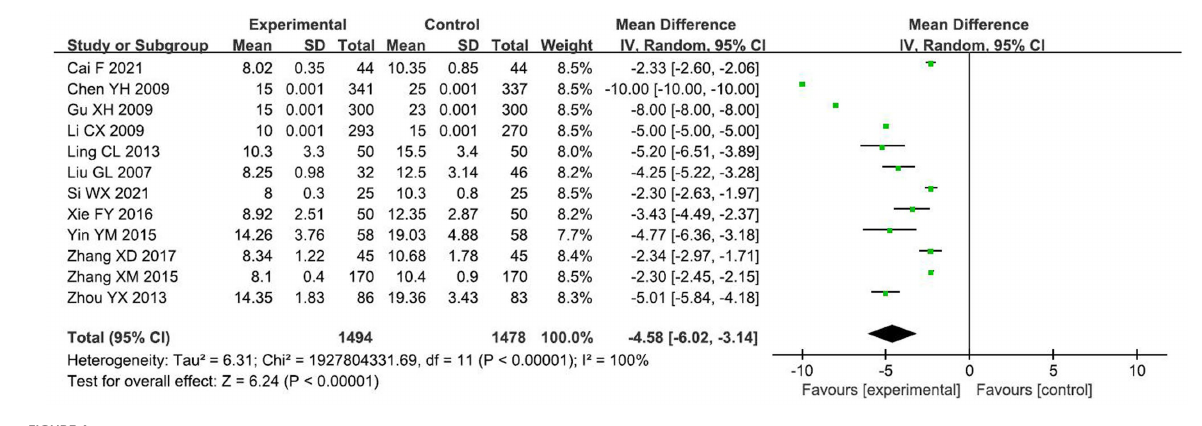
FIGURE 4 Comparison of incision suture time between the two groups.